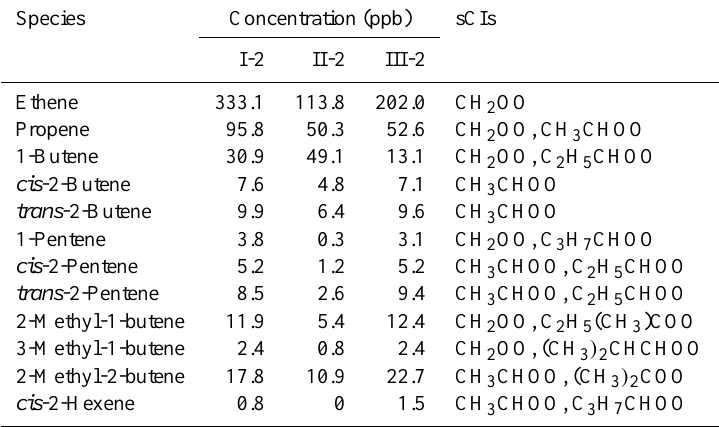
Table 4. Concentrations of alkenes included in the model and the category of sCIs.